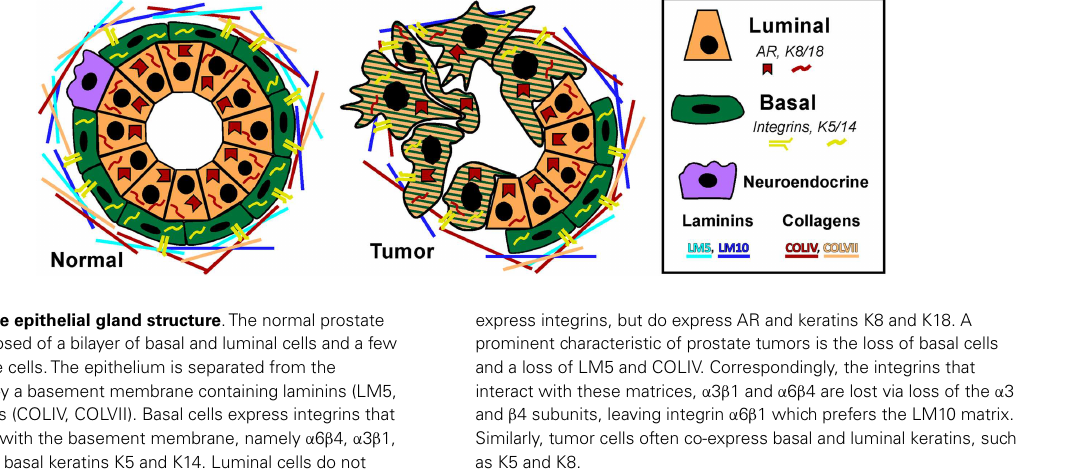
FIGURE 1 | Prostate epithelial gland structure .The normal prostate epithelium is composed of a bilayer of basal and luminal cells and a few rare neuroendocrine cells.The epithelium is separated from the underlying stroma by a basement membrane containing laminins (LM5, LM10) and collagens (COLIV, COLVII). Basal cells express integrins that specifically interact with the basement membrane, namely α 6 β 4, α 3 β 1, and α 2 β 1 as well as basal keratins K5 and K14. Luminal cells do not